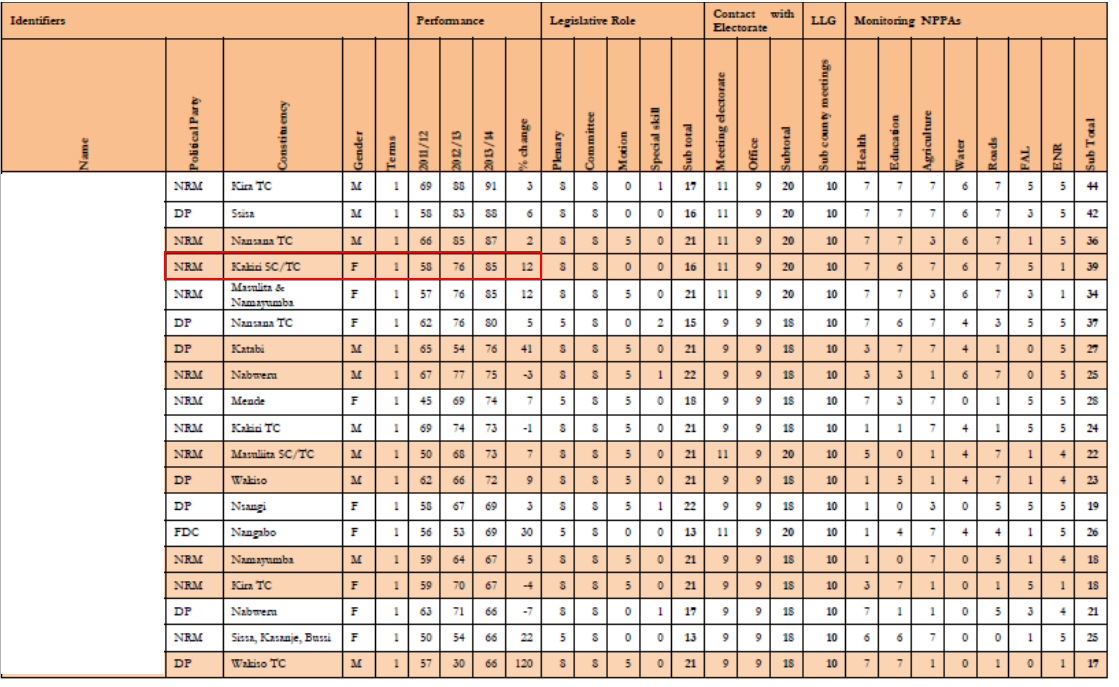
Figure 2: Summary of performance for district councillors (FY